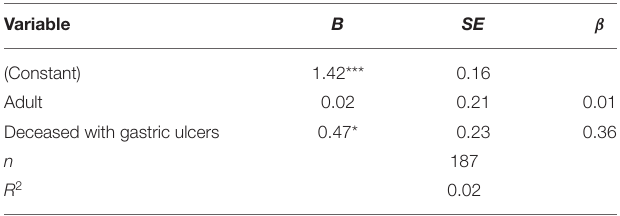
TABLE 3 | Multiple linear regression estimation for number of clinically relevant affected organs/organ